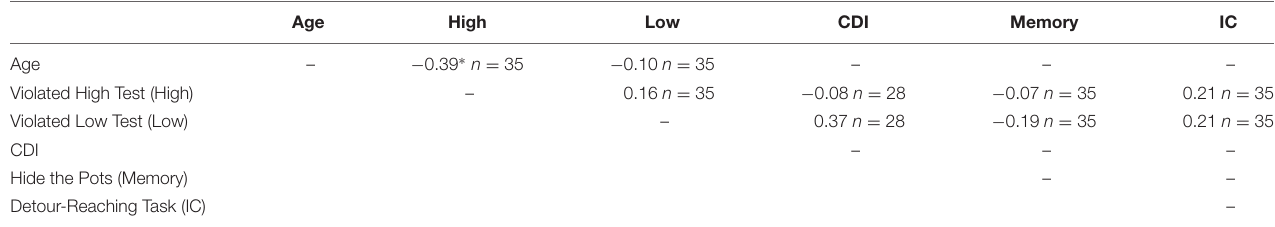
TABLE 7 | Zero-order correlations between age, performance on the inductive inference task, working memory and inhibitory control in the Distinct Label Group only.